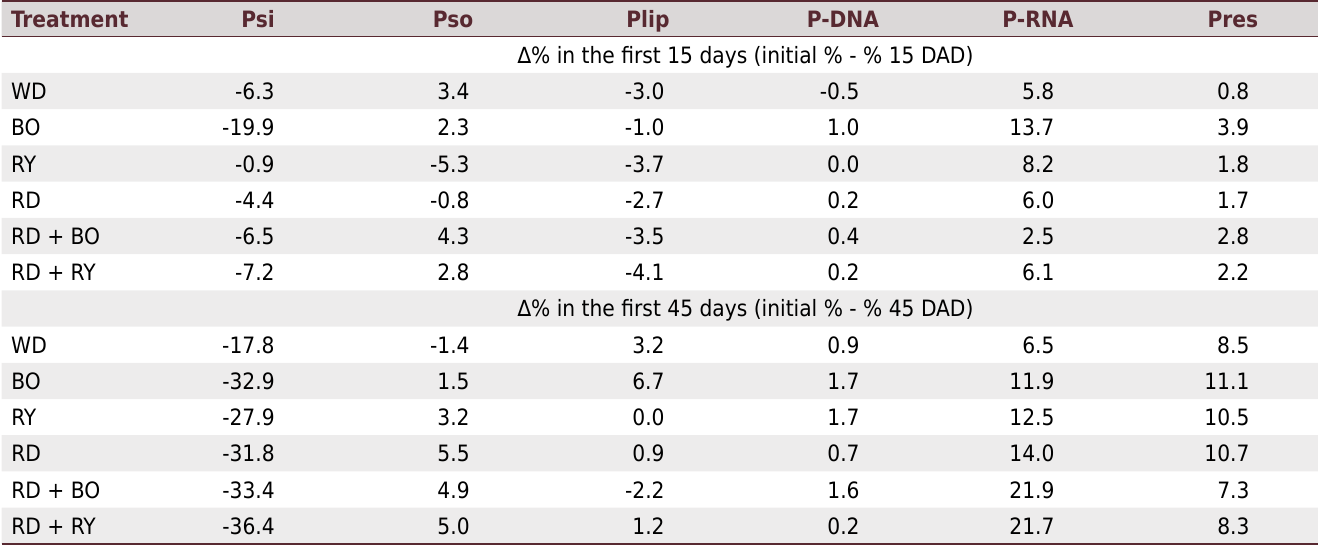
Table 3. Difference in the relative proportion of phosphorus forms between the sampling times of weed (WD), black oat (BO), rye (RY), oilseed radish (RD), oilseed radish + black oat (RD + BO), and oilseed radish + rye (RD + RY) residues Treatment Psi Pso Plip P-DNA P-RNA